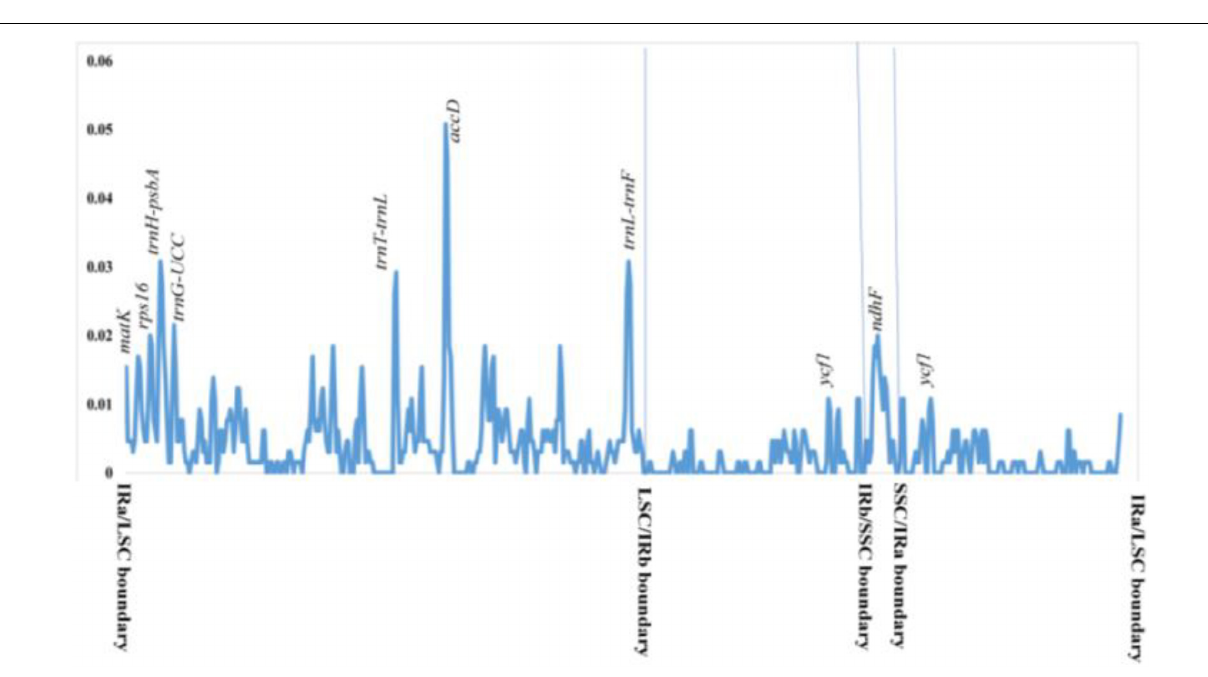
FIGURE 4 | Nucleotide diversity (Pi) in 31 Hoya group complete plastomes. The values represent different diversity for different genes and